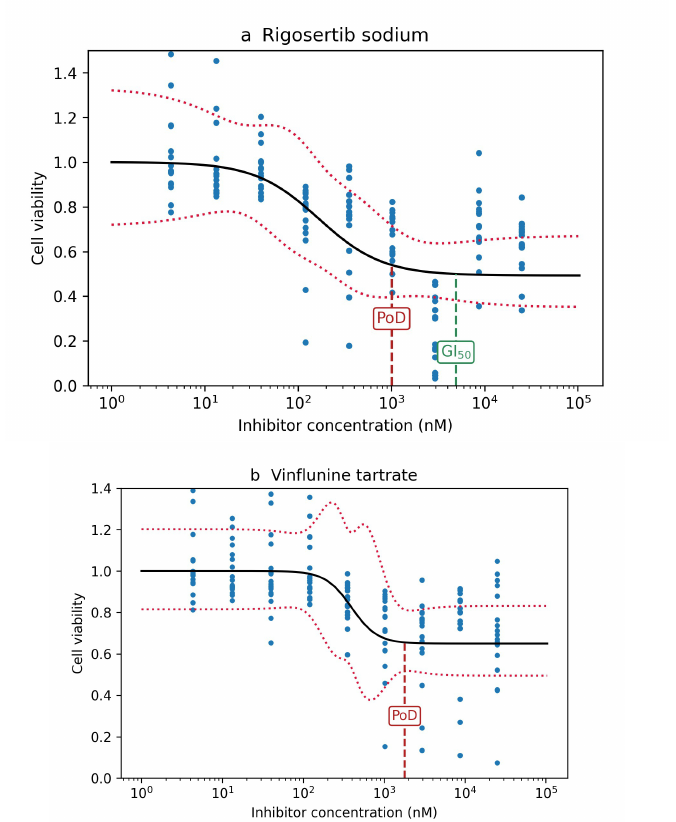
Figure 8. ( a ) Rigosertib sodium leveled off shortly after reaching GI 50 . ( b ) Vinflunine tartrate leveled off before reaching GI 50